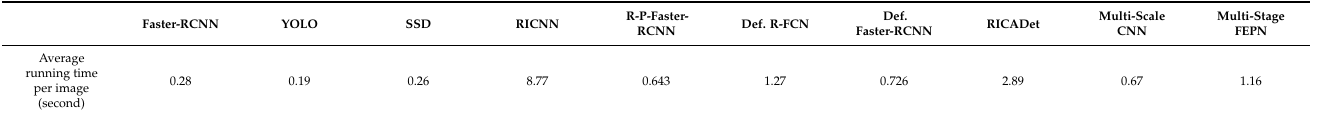
Table 5. The average running time of different frameworks.